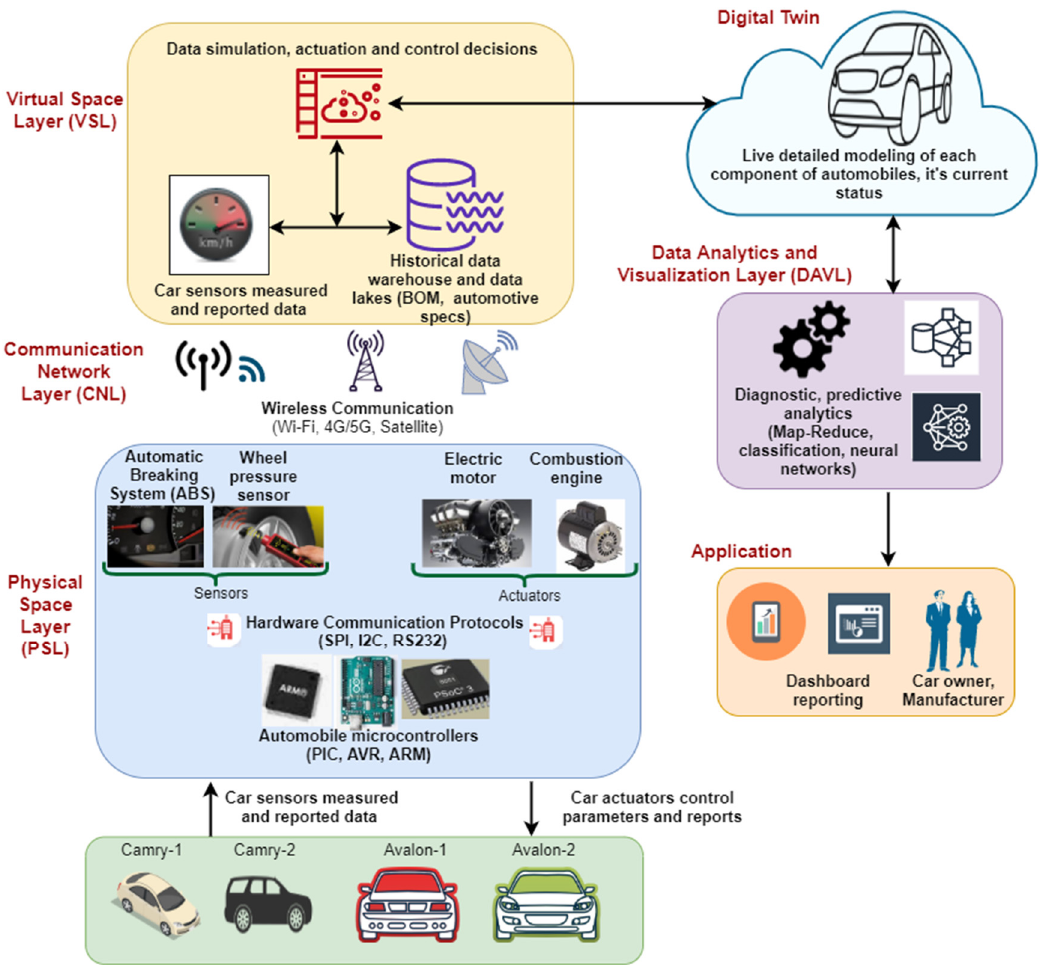
Figure 3. Proposed end-to-end digital twin conceptual model for vehicles.